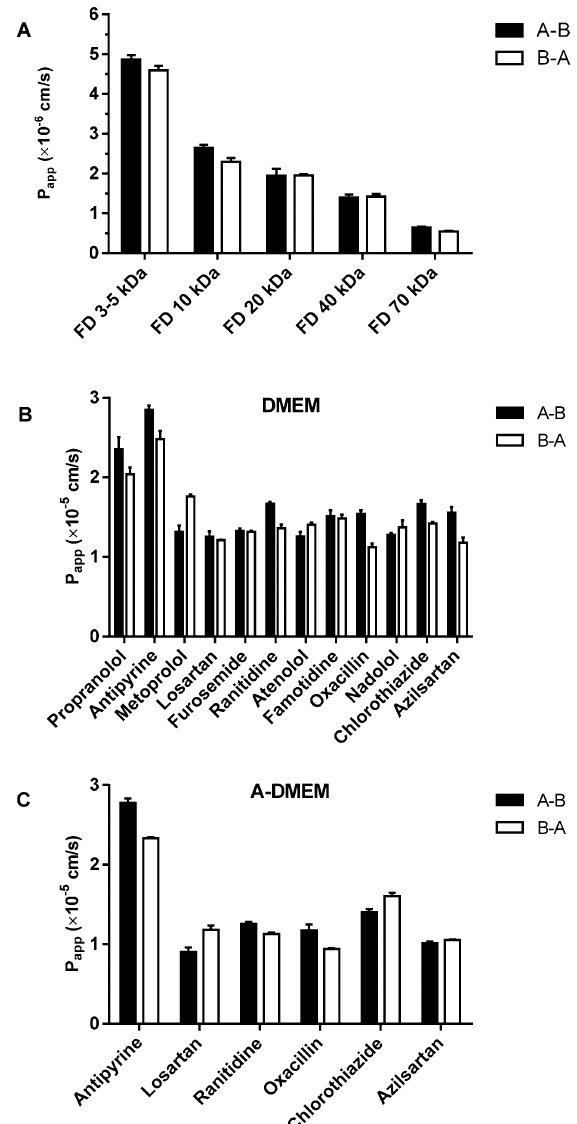
Figure 10. Average apparent permeability coefficients (P app s) in A-B and in B-A direction of: ( A ) zero permeability paracellular markers FITC-dextrans (FDs) with different MW, determined in the short-term 1wk FLO-1 model cultured in DMEM; ( B ) model drugs in FLO-1 cell model cultured in DMEM for 1 wk and; ( C ) model drugs FLO-1 cell model cultured in A-DMEM for 1 wk. N ≥